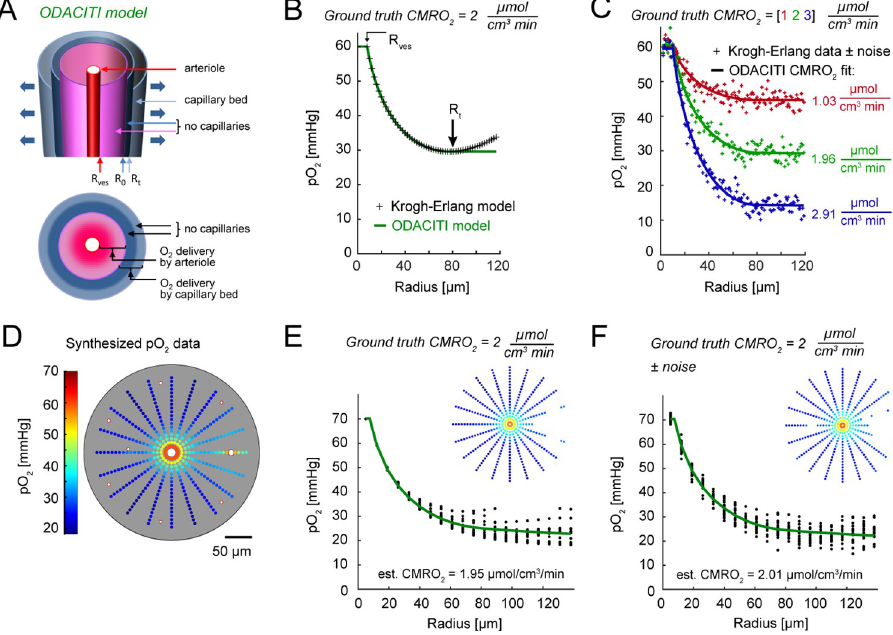
Fig 2. ODACITI model and validation with synthetic data. (A) Schematic illustration of the model assumptions. The center arteriole is the only source of O 2 for the pink periarteriolar region void of capillaries extending out to radius r = R t . For r > R t , delivery and consumption are balanced. (B) Comparison of the functional form of the Krogh–Erlang (black) and ODACITI model (green). The Krogh–Erlang model but not ODACITI forces an increase in partial pressure of O 2 (pO 2 ) beyond R t . (C) Application of ODACITI to synthetic data with added Gaussian noise ( σ = 2). In these data, pO 2 = P ves for r < R ves and pO 2 = pO 2 ( R t ) for r > R t . For R ves < r < R t , we solved for pO 2 using the Krogh– Erlang equation. Three cases with cerebral metabolic rate of O 2 (CMRO 2 ) of 1, 2, and 3 μ mol cm − 3 min − 1 (color- coded) are superimposed. For each case, the ODACITI fit (solid line) is overlaid on the data points. (D) Simulated pO 2 data generated by solving the Poisson equation in 2D for a given geometry of vascular O 2 sources, including 1 highly oxygenated vessel (on the right) and given CMRO 2 = 2 μ mol cm − 3 min − 1 . (E) The pO 2 gradient as a function of the distance from the center arteriole. The green line shows ODACITI fit. (F) As in (E) after adding Gaussian noise ( σ = 2 SD). Numerical values for (B, C, E, and F) are provided in S1 Data (sheets 2B, 2C, 2E, and